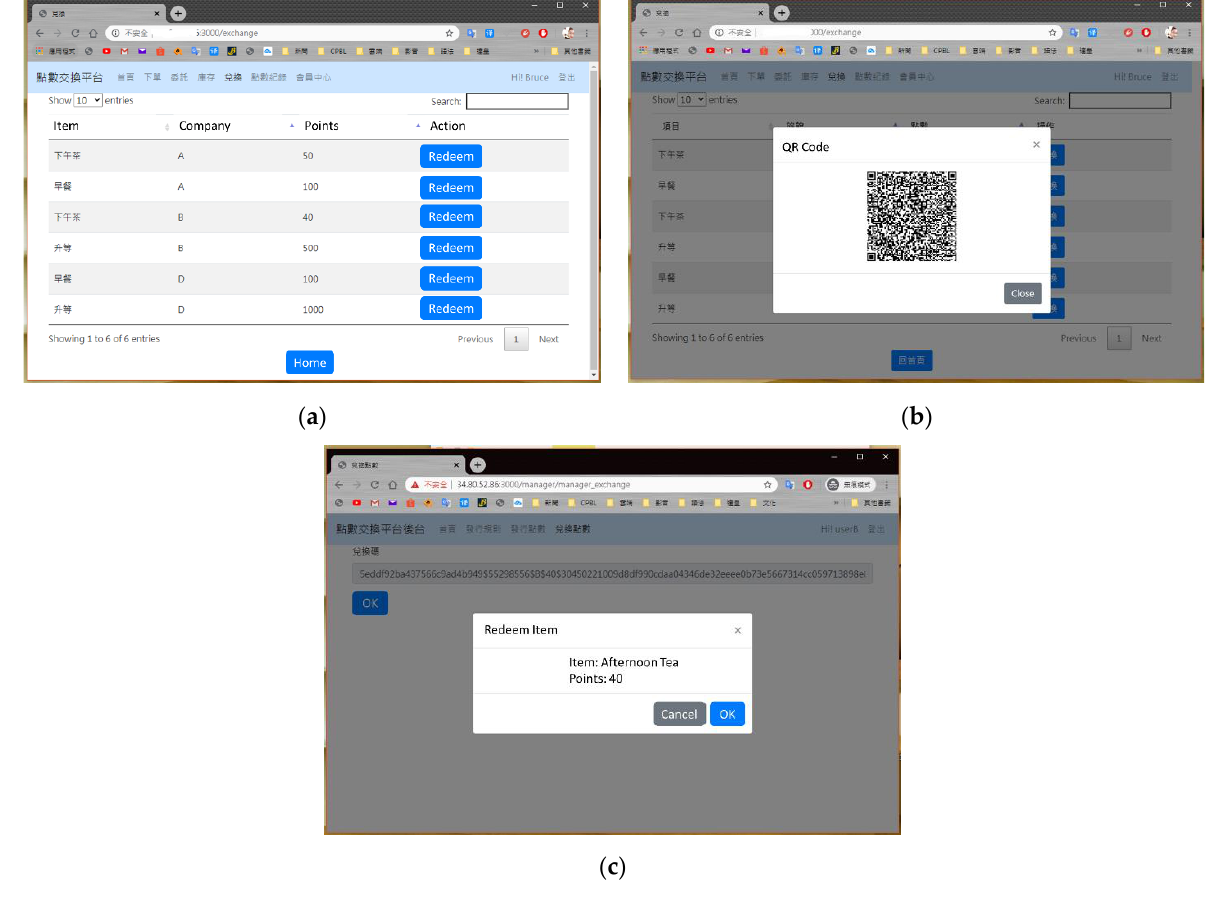
Figure 6. User interface of redemption.